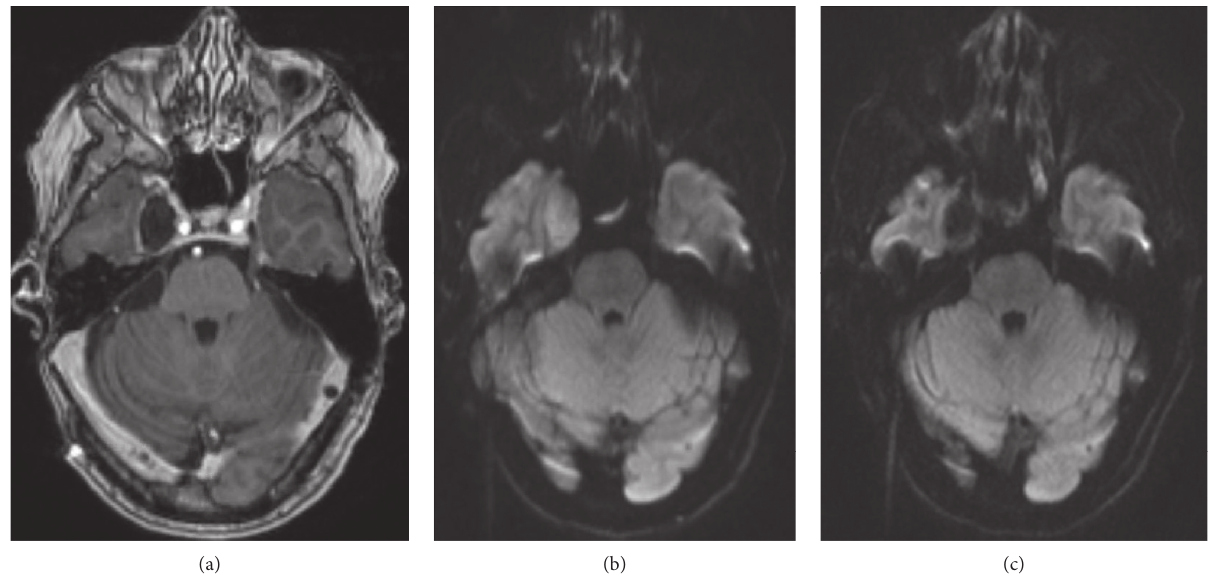
Figure 1: Imaging of patient 1. (a) Preoperative contrast-enhanced axial T1 MRI showing peripheral enhancement of the cyst wall.